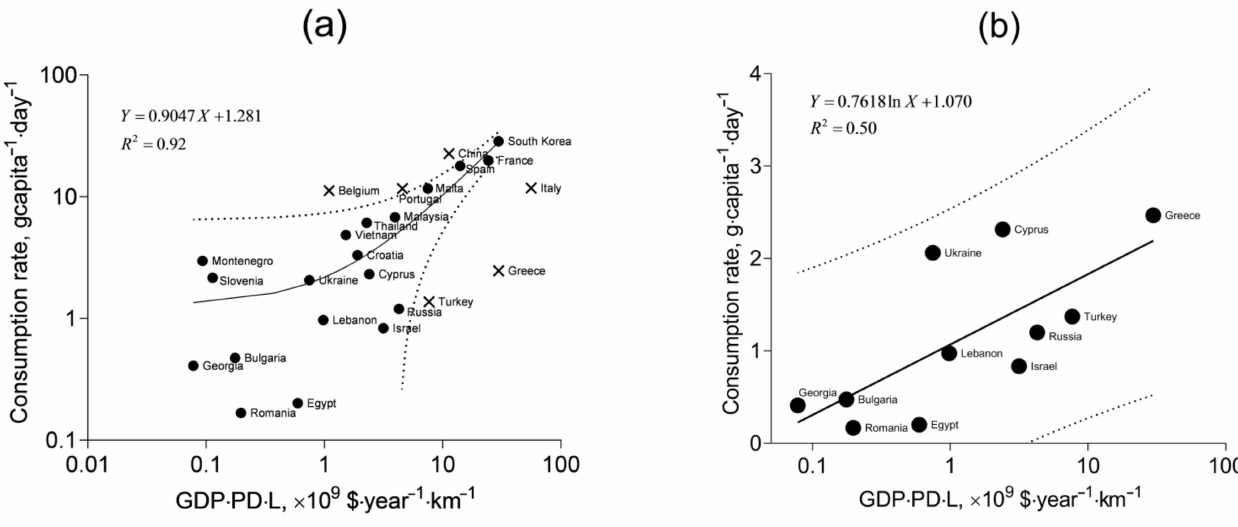
Figure 6. Mollusk consumption rates correlated with the gross domestic product per capita at purchasing power parity (GDP), population density (PD), and coastline length (L): ( a ) all selected countries, linear fit, and ( b ) low-consuming countries, logarithmic fit. Dotted lines: 95% prediction band boundaries. Crosses: outliers neglected in the